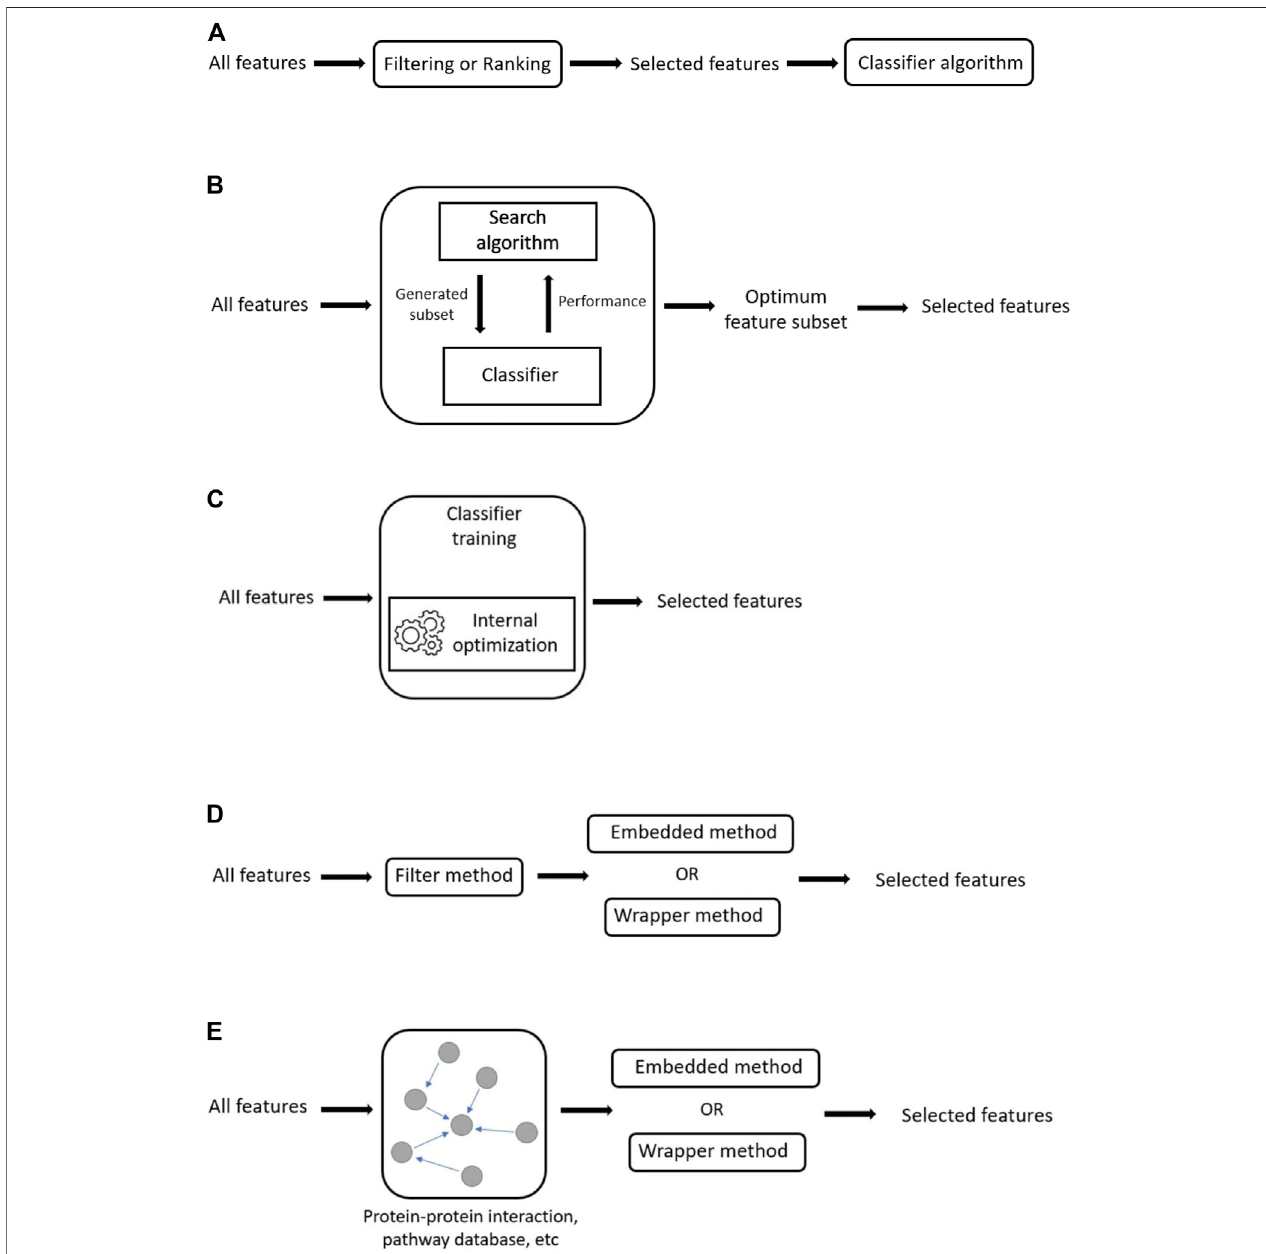
FIGURE 5 | Generalized illustrations of methods. (A) Schematic of fi lter method, where feature selection is independent of the classi fi er. (B) The wrapper method. Feature selection relies on the performance of the classi fi er algorithm on the various generated feature subsets. (C) The embedded method. In embedded methods, feature selection is integrated as apart of the classi fi er algorithm. (D) Hybrid methods. In hybrid methods, features are reduced through the application of a fi lter method beforethereducedfeaturesetispassedthroughawrapperorembeddedmethodtoobtainthe fi nalfeaturesubset. (E) Integrativemethods.Inintegrativemethods, externalinformationisusedasa fi ltertoreducefeaturesearchspacebeforethereducedfeaturesetispassedthroughawrapperorembeddedmethodtoobtainthe fi nal feature